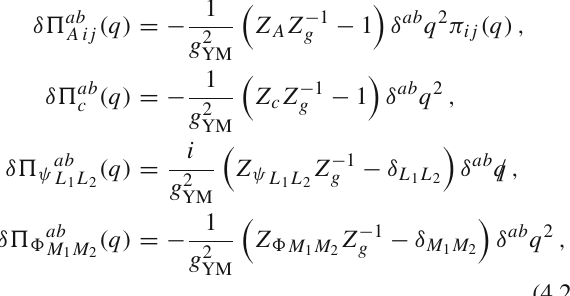
Differently from the d = 3 case, in d = 4 dimensions the UV singularities already appear at 1-loop level through a 1 /( d − 4 ) pole in the G 1 function, and at 2-loop as single and double poles. On the other hand, the IR singularities do not affect the 2-point functions. These divergences can be absorbed, as usual, in the redefinition of the fields ϕ → Z 1 / 2 ϕ , through the wave-function renormalisation constants, and of the couplings. In particular, the UV divergences of the 2-point functions are removed by counterterms extracted from the kinetic part of the action. These are given